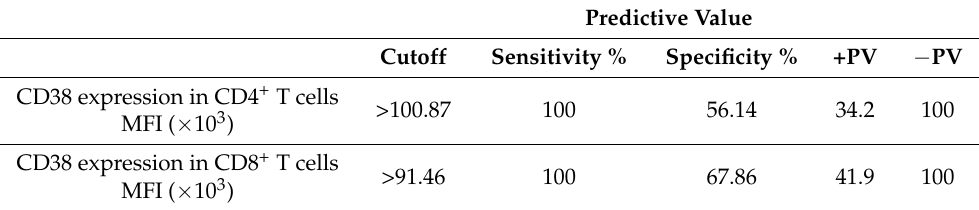
Table 9. The cut-off value for CD38 expression (MFI × 10 3 ) in Th CD4 + T cell and Tc CD8 + T cell subtypes as a predictor of mortality among patients of the three studied groups.